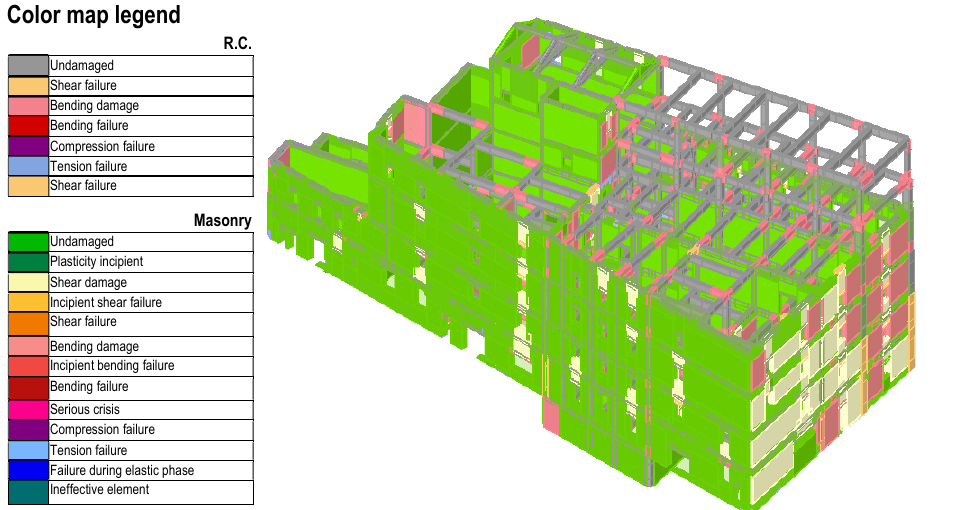
Figure 20. Structural damage at the last step of seismic analysis n.21, direction Y (Uniform).